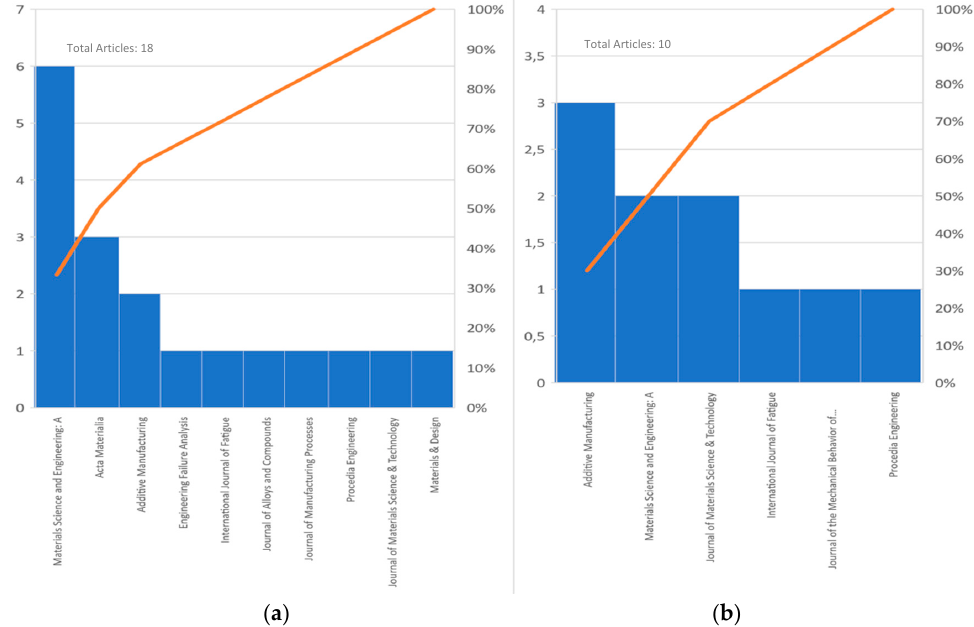
Figure 6. Pareto’s charts of the research, ( a ) “Heat Treatments + Electron Beam Melting + Ti–6Al–4V”, and ( b ) “Residual Stresses + Electron Beam Melting + Ti–6Al–4V”, on ScienceDirect.